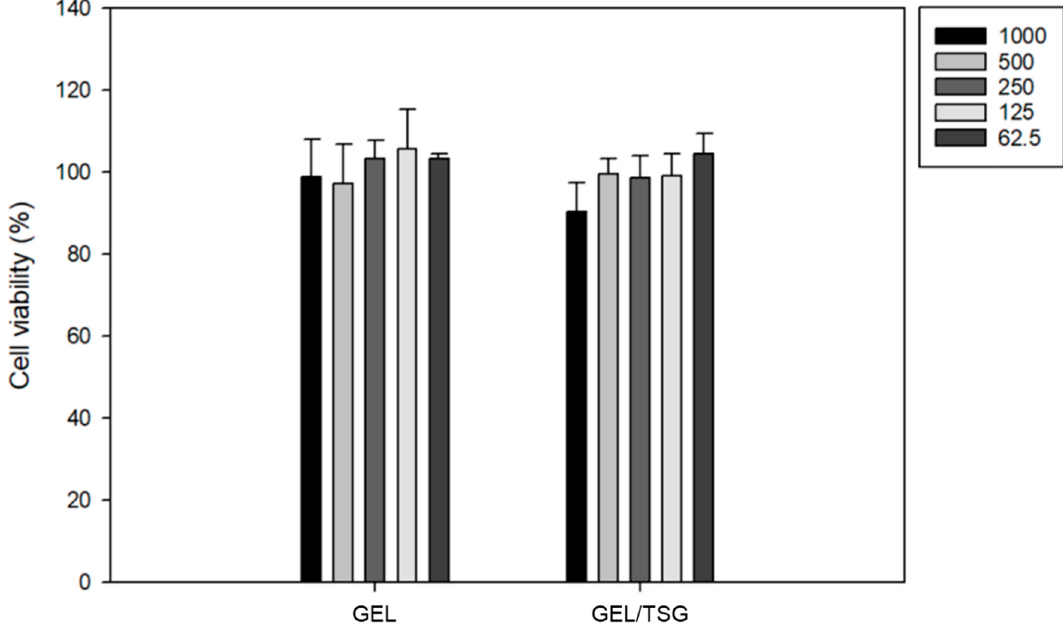
Figure 1. MTT assay of only gellan gum (GEL) and GEL / tuna skin gelatin (TSG). Cell viability remained unchanged.